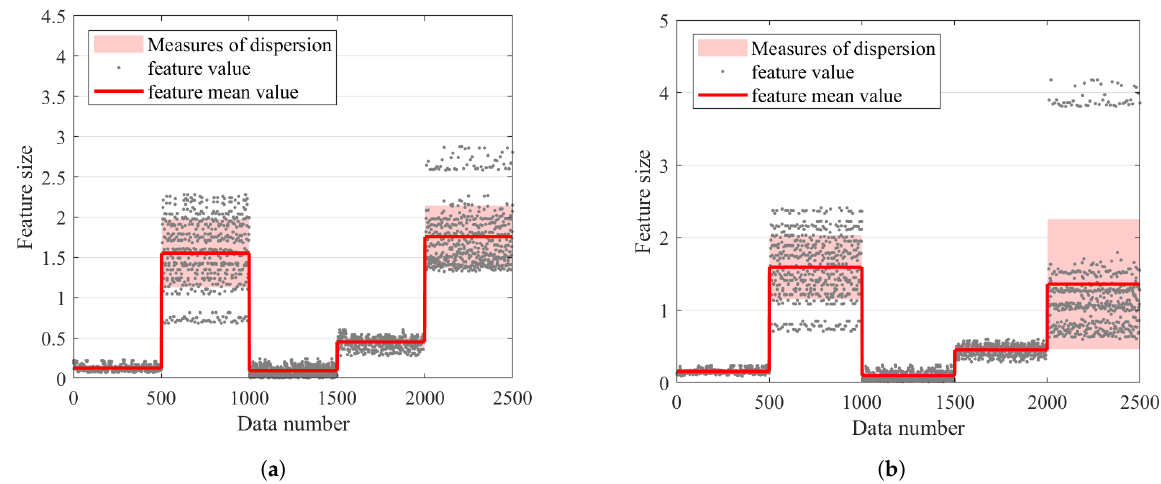
Figure 7. The distribution of the most sensitive feature in different training set. ( a ) Feature distribution of nominal model with LESO. ( b ) Feature distribution of nominal